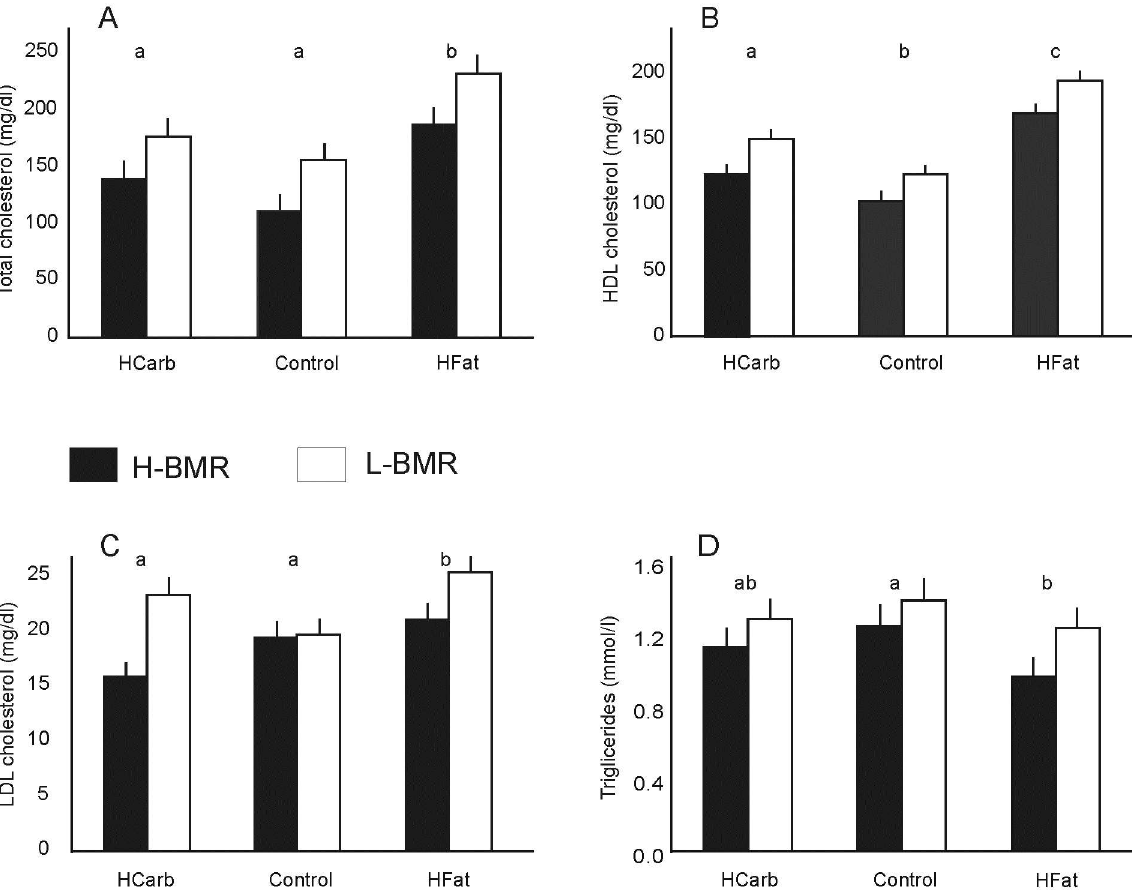
Fig 3. Lipid profile: total cholesterol (A), HDL cholesterol (B), LDL cholesterol (C) and triglyceride (D) blood levels in mice fed the HFat, HCarb and Control diets. Data presented as least squaremeans ± s.e.m. Different letters (a,b,c) show significant